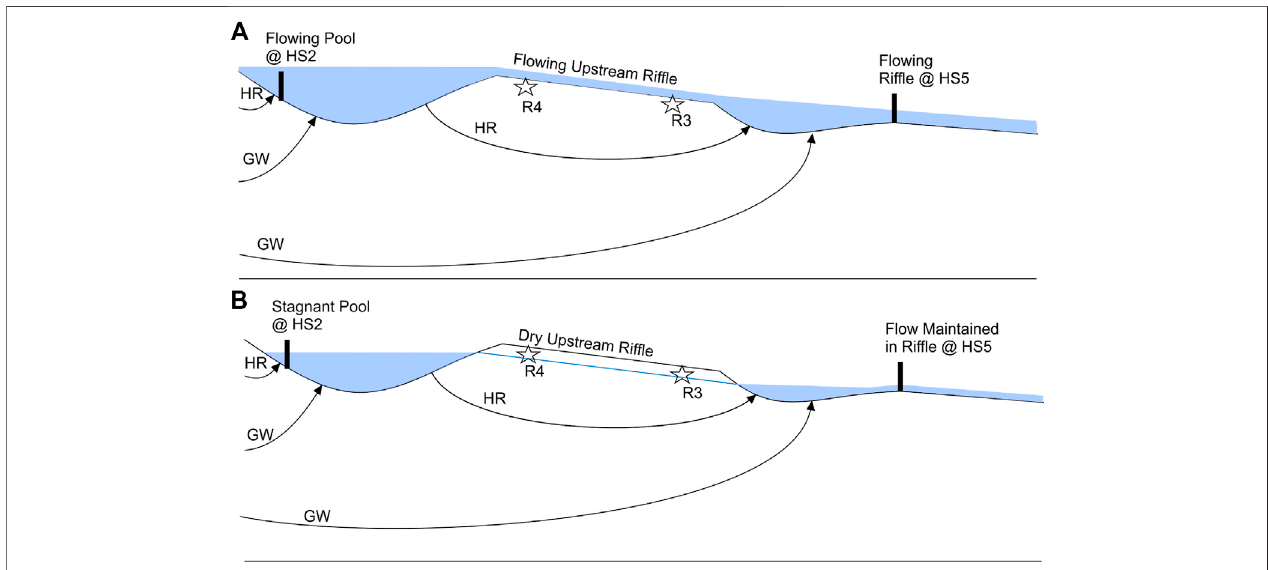
FIGURE 11 | Conceptual model of surface and subsurface fl ow at Otter Park during (A) fl owing phases and (B) periods of fl ow cessation. The stream section located between the intermittent rif fl eand HS5 ( Figure 3 ) wasomitted tohighlight thefocal segmentsofthe study reach. During fl owing phases (A) , surface fl owoccurs ineach habitat unit.Verticalexchanges intheupstream pool anddownstreamrif fl eareconstitutedbyhyporheic (HR) andgroundwater(GW) fl ow.Duringperiodsof fl ow cessation (B) , surface fl ow persists only in the downstreamrif fl e. The upstream rif fl ewhere sites R4and R3are located dries when fl ow ceases in thepool. HRand GW fl ow paths help maintain water level in the upstream pool, which supplies water to the downstream rif fl e via HR fl ow paths.